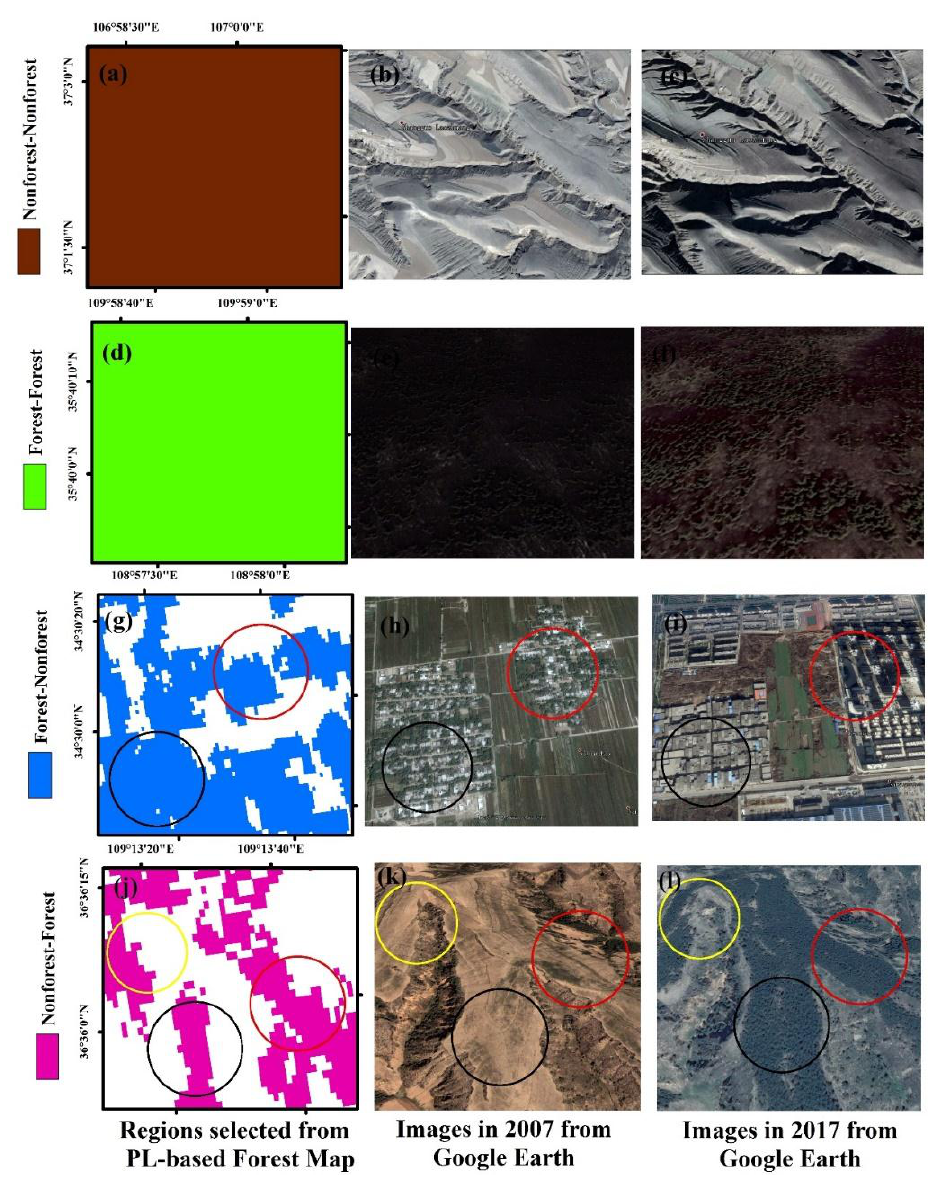
Figure 10. Verification of changed areas and unchanged areas using Google Earth on the Loess Plateau between 2007 and 2017. Nonforest areas to Nonforest areas ( a – c ), Forest areas to Forest areas ( d – f ), Forest areas to Nonforest areas ( g – i ), and Nonforest areas to Forest areas ( j – l ).